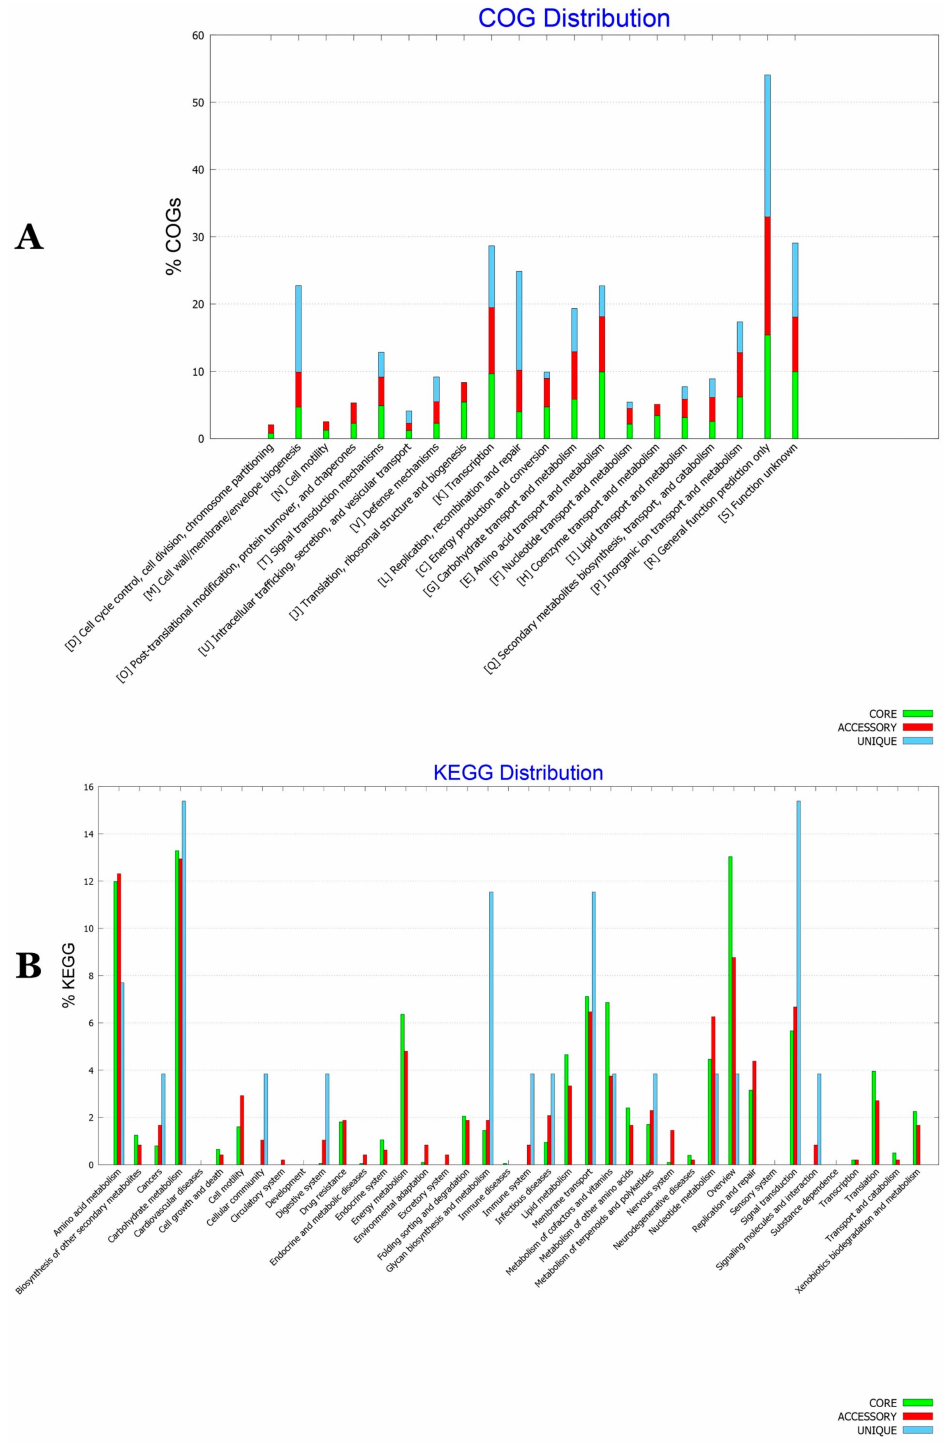
Figure 11. COG ( A ) and KEGG ( B ) distribution among core, accessory and unique genomes of BA